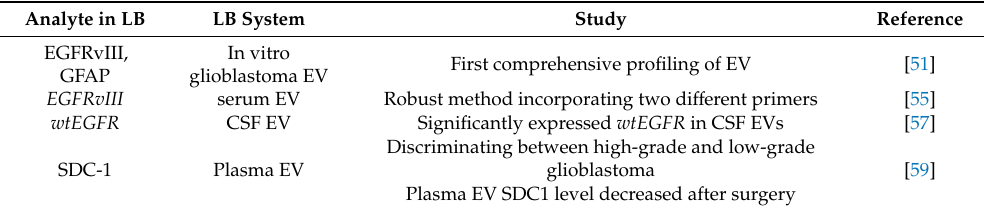
Table 2. Potential targets in glioblastomas for diagnosis with liquid